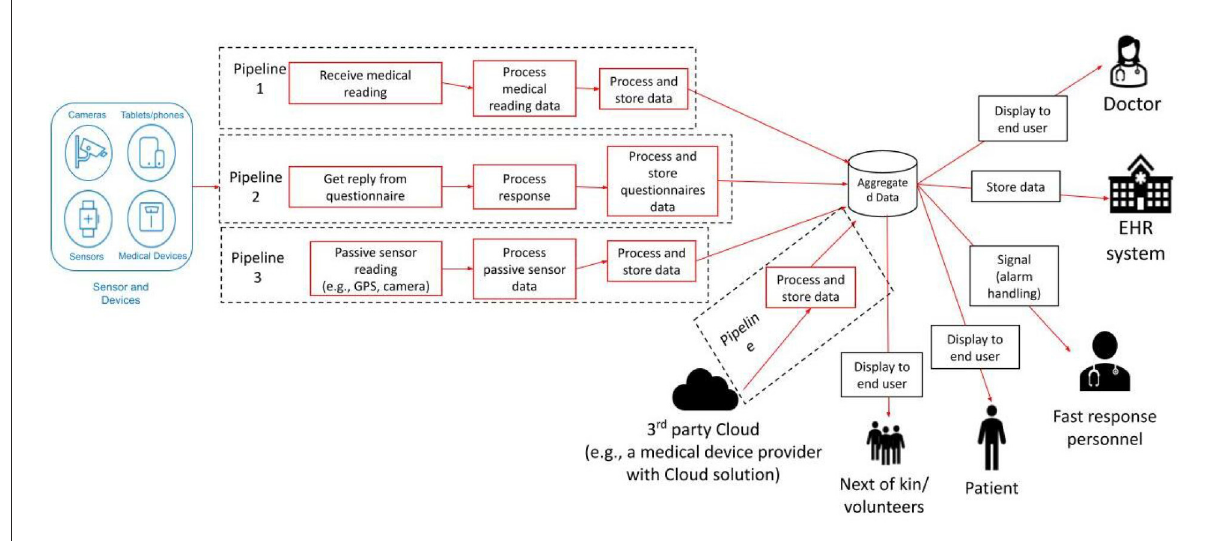
FIGURE3 Typical data flows of a e-Health system in a Smart City